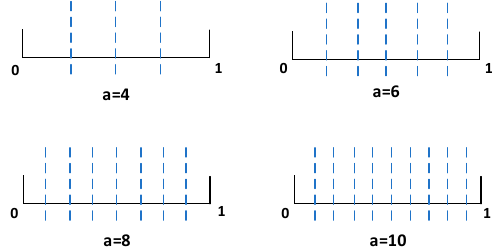
Figure 5. Division of the hop count interval [0,1].